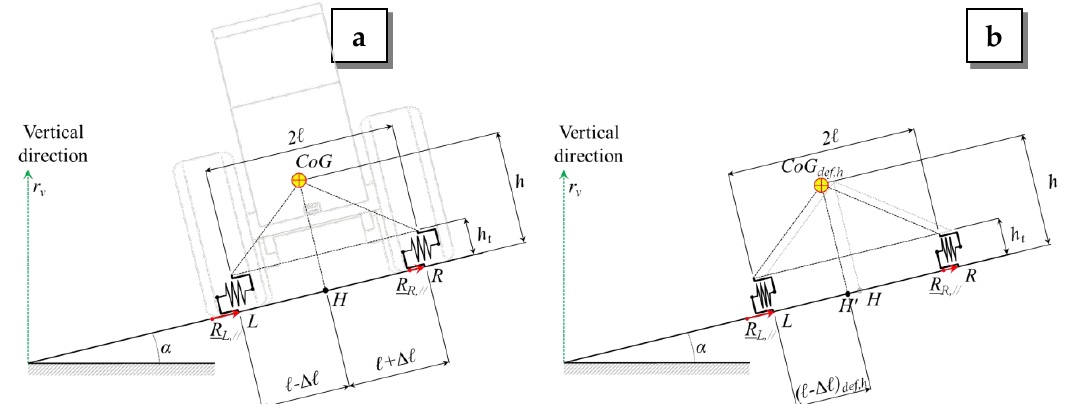
Figure 15. Graphical representation of the effect of a pure lateral solicitation of the tyres due to the weight component in the direction parallel to the support plane, supported by each tyre (( a ) initial situation–tyres not deformed; ( b ) final situation–tyres deformed).